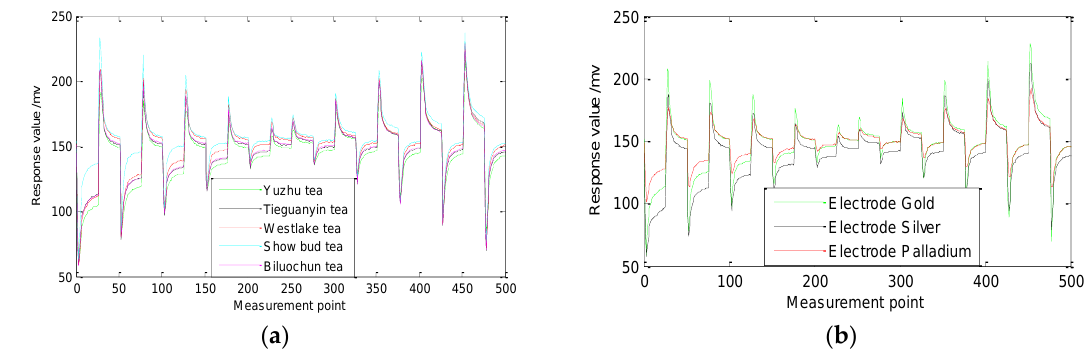
Figure 5. ( a ) The response of five kinds of tea upon silver working electrodes (WE); ( b ) the response of Tieguanyin tea upon different WE (Gold, Silver, Palladium).